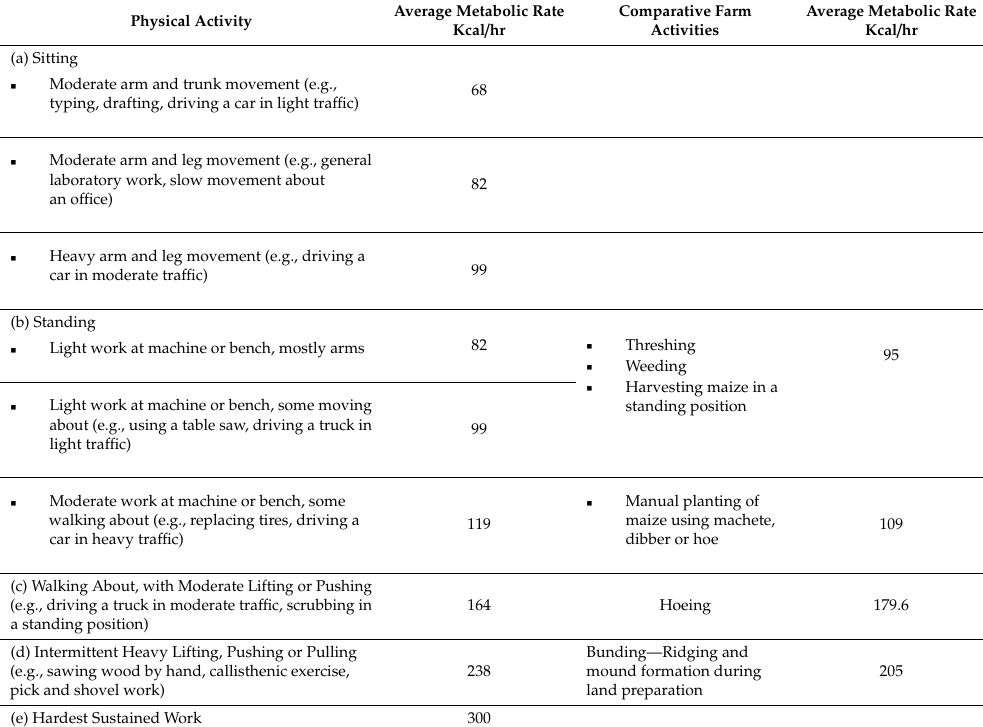
▪ Caused by the loss of body salts and fluid during